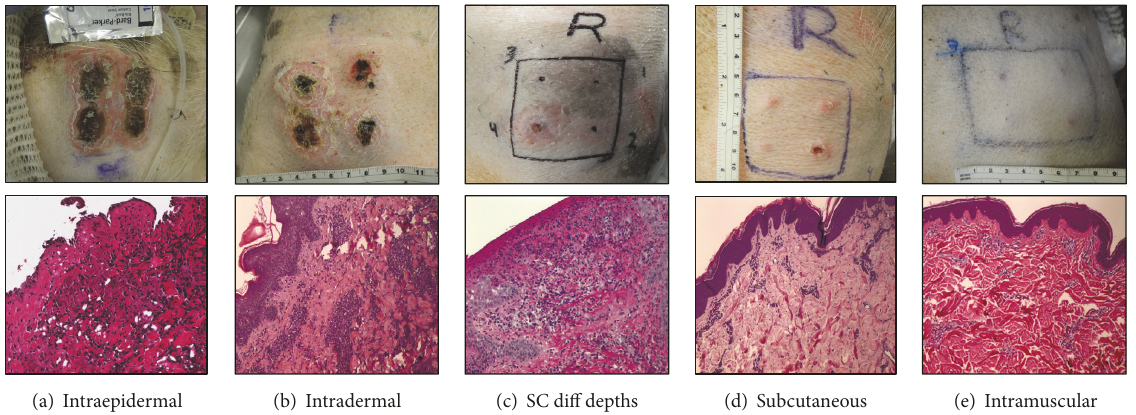
Figure 2: Macroscopic appearance of CFA injection into different cutaneous spaces at day 9 after injection (a) and histologic evaluation of the inflammatory infiltration